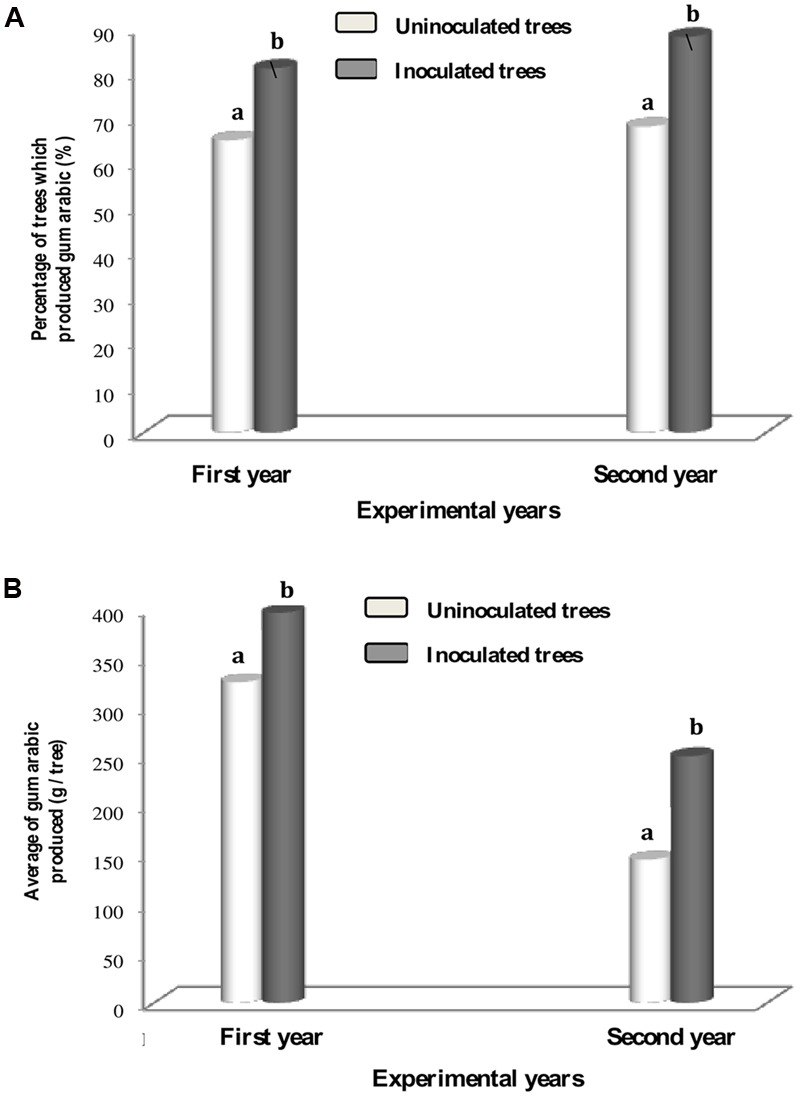
Percentage of gum arabic producing trees (A) and the yield of gum arabic produced (B) by uninoculated and inoculated 13-year-old S. senegal trees in 1st and 2nd year. For each year, bars with same letter comparing rhizobial inoculation effect are not significantly different at P < 0.05 (Newman–Keuls test).